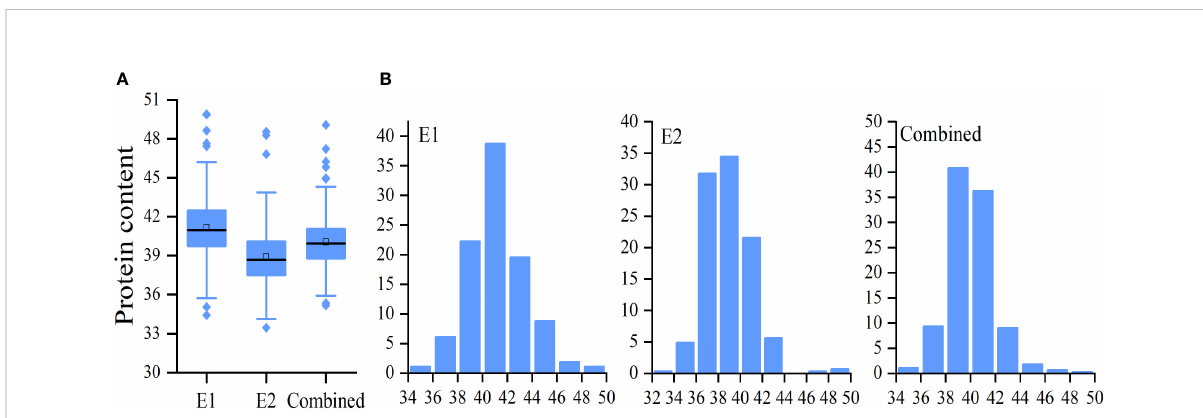
FIGURE 1 Distribution of soybean seed protein content (PC). Boxplot (A) and frequency distribution (B) of soybean seed PC in E1, E2, and combined environment,